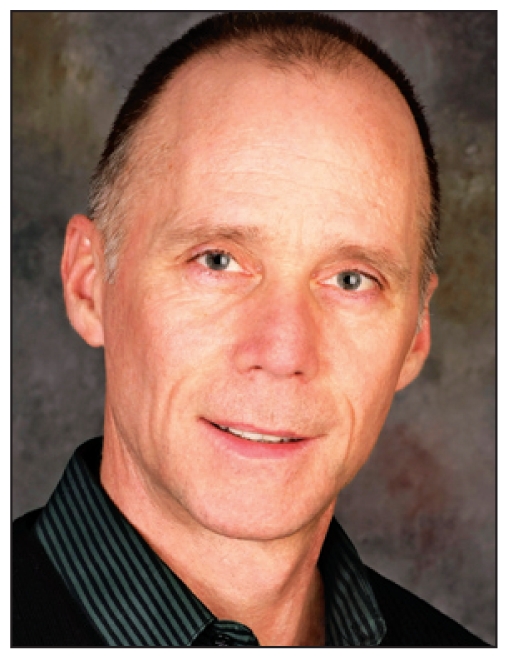
Matthew Longnecker